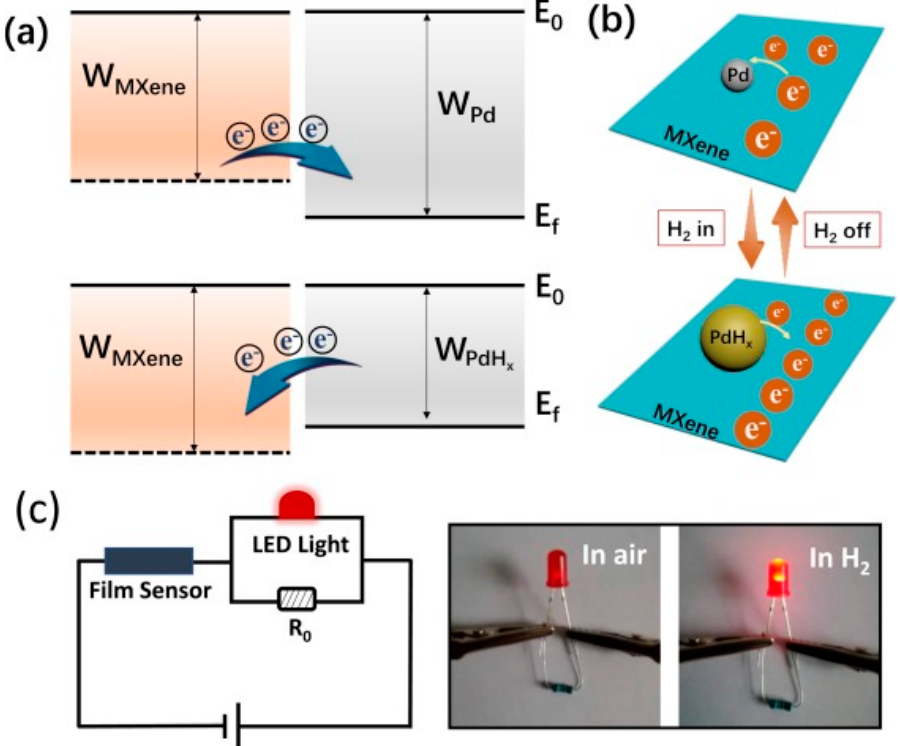
Figure 38. ( a ) Energy band diagrams of Pd and MXene before and after H 2 exposure, and ( b ) the diagram of surface H 2 adsorption and electron transfer between Pd colloidal nanoclusters (CNC) and MXene. The significantly lowered work function of PdH x has driven the electron transfer back from Pd/PdHx to MXene, resulting in the electron doping of MXene and therefore the resistance decrease. ( c ) An alarm circuit design for H 2 leaks detection using one piece of MXene@Pd CNC film sensor and LED bulb, and photographs indicating the LED bulb was turned on after H 2 exposure. Reprinted with permission from [174]. Copyright 2020: Elsevier B.V.